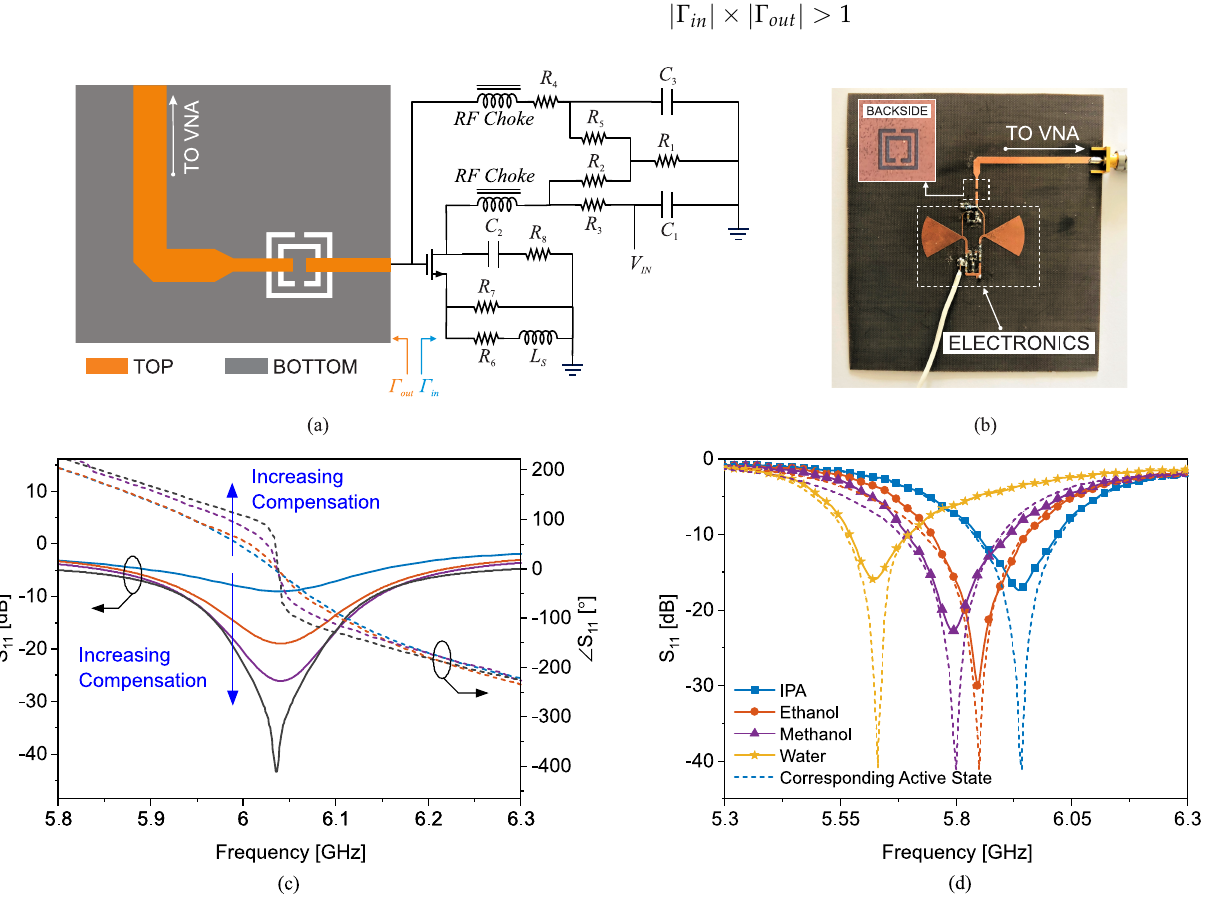
Figure 41. Reflection sensor loss-compensated design with preliminary results: ( a ) schematic of the active reflection-based sensor; ( b ) fabricated sensor prototype; ( c ) Measured amplitude and phase of reflection parameter S 11 with different loss compensation states from blue (no compensation) to black (high compensation); and ( d ) measured S 11 for different Materials including IPA, ethanol, methanol and water. Reprinted with permission from Ref.